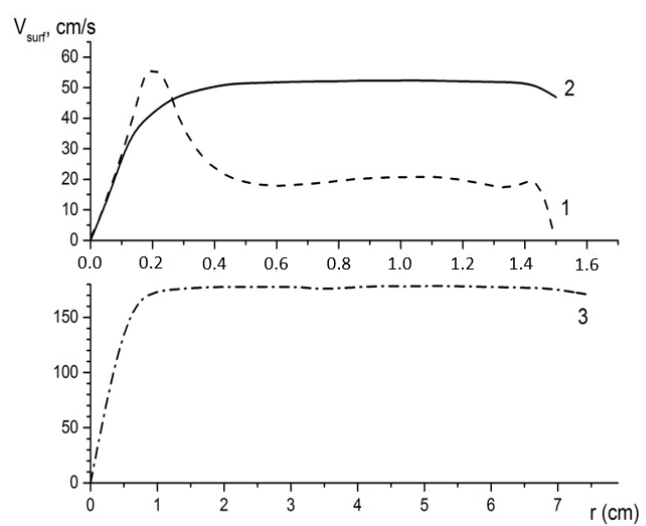
Figure 10. Radial distribution of the horizontal flow velocity V surf near the crystal surface (projection on the crystal surface) for 1—laminar central straight flow, V je t = 90 cm/s; 2—laminar peripheral swirl flow, V jet = 55 cm/s; and 3—turbulent peripheral swirl flow, V jet = 200 cm/s.